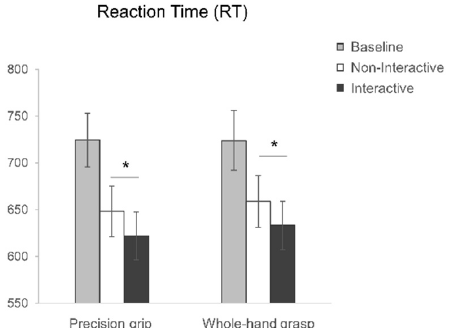
Figure 3. Reaction Time (RT) results for precision grip (PG) and whole-hand grasp (WHG) actions performed in the Baseline (grey), Non-Interactive (white) and Interactive (black) conditions. The error bars represent standard error of the mean. Asterisks indicate significant differences ( p < 0.05) between conditions (planned contrasts).